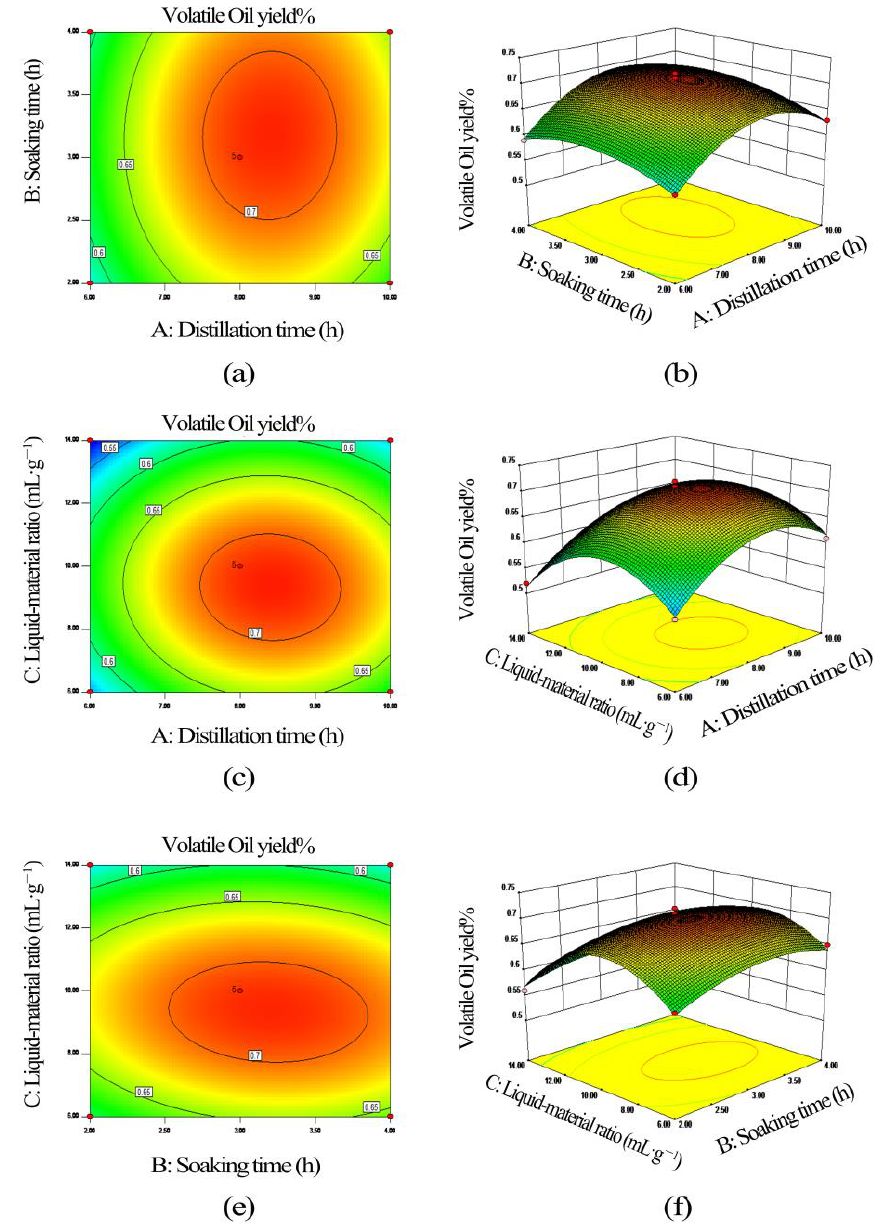
Figure 7. The 3D response surface and 2D contour map for the distillation process of volatile oil.